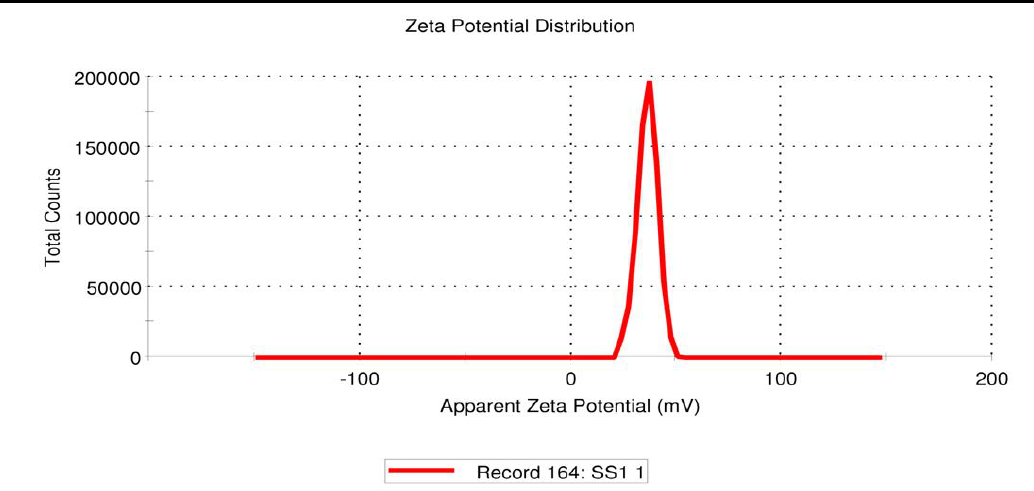
Figure 8. Zeta potential of SGN–TC nanoparticles (F3).